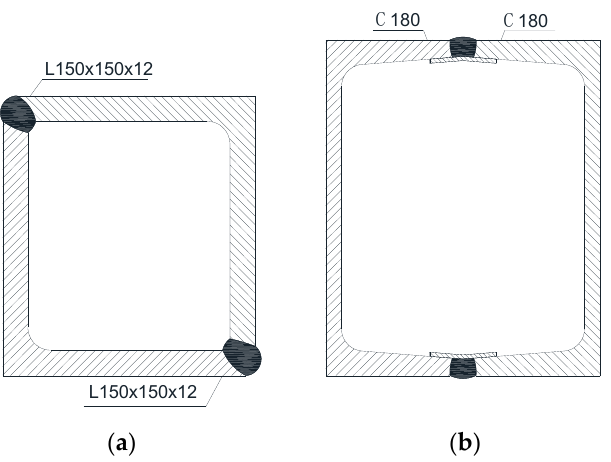
Figure 2. Cross-section of the ( a ) bunton and ( b ) guide in the examined shaft.